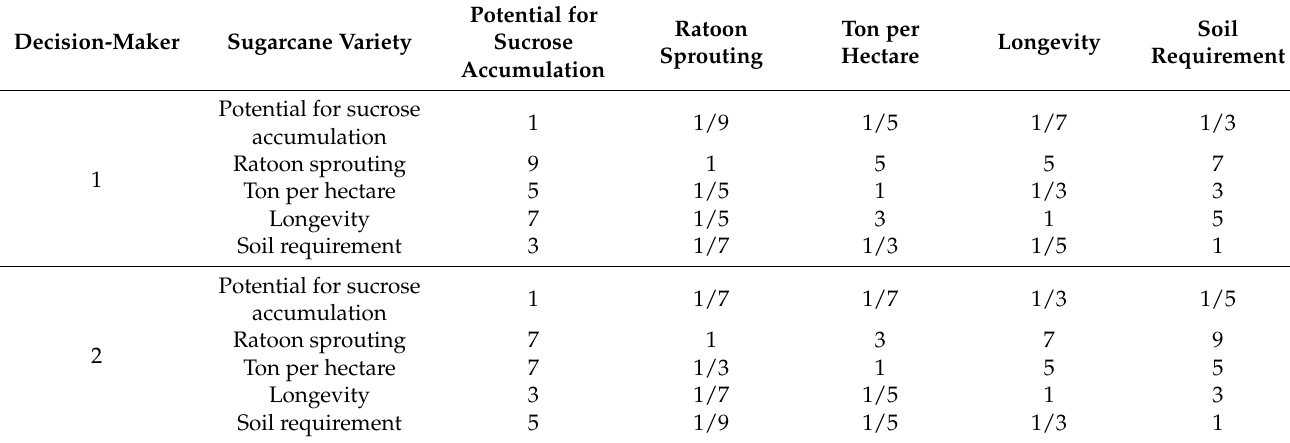
Table 4. Criterion comparison matrix of each variable and sugarcane variety for both